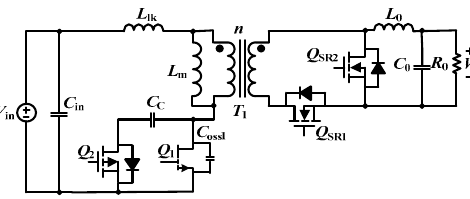
Figure 2. Comparison of the clamp capacitor voltage for different clamp circuit.